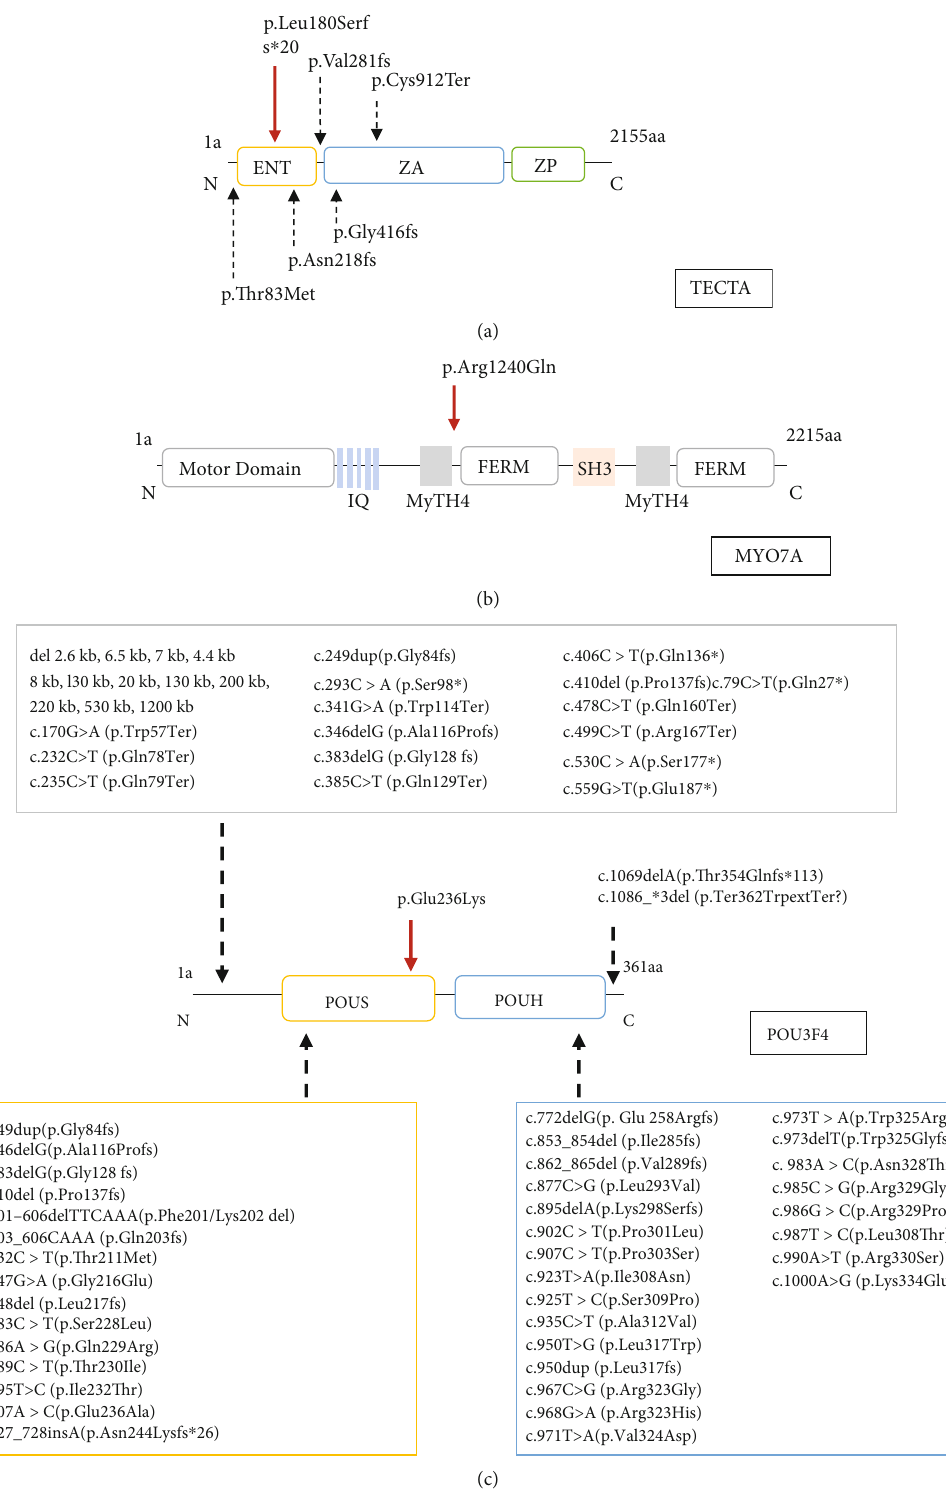
Figure 4: Domain structure and variant position of TECTA, MYO7A, and POU3F4 proteins. (a) α -Tectorin consists of entactin domain (ENT), zonadhesin (ZA) domain, and C-terminal zona pellucida (ZP) domain. Previously reported autosomal recessive variants in TECTA are presented, with the c.536del (p. Leu180Serfs ∗ 20) variant highlighted by the red arrow. (b) Myosin VIIA consists of a motor domain, fi ve IQ motif repeats, two large repeats of MyTH4 and FERM domains, and an SH3 domain. The c.3719 G > A (p. Arg1240Gln) variant is highlighted by the red arrow. (c) POU3F4 consists of a POU-speci fi c domain (POUS) and a POU homeodomain (POUH). Previously reported POU3F4 variants are presented, with the c.706G > A (p. Glu236Lys) variant highlighted by the red